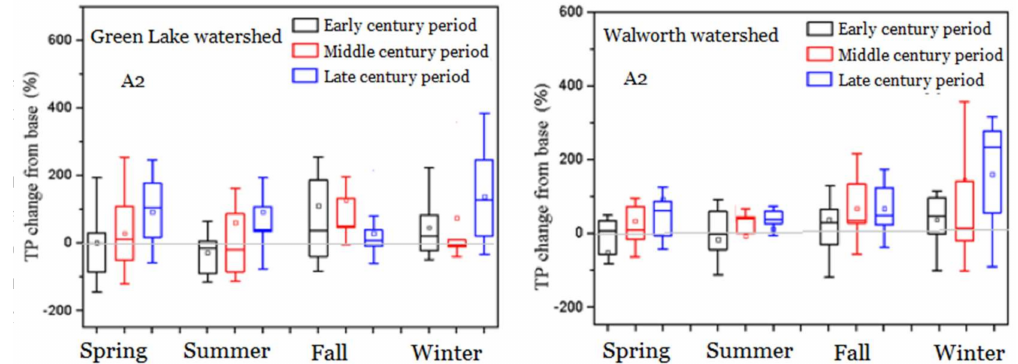
Figure 6. Seasonal changes of TP losses at the Green Lake watershed and Walworth watershed under the A2 scenarios. ( left ): Green Lake watershed, ( right ): Walworth